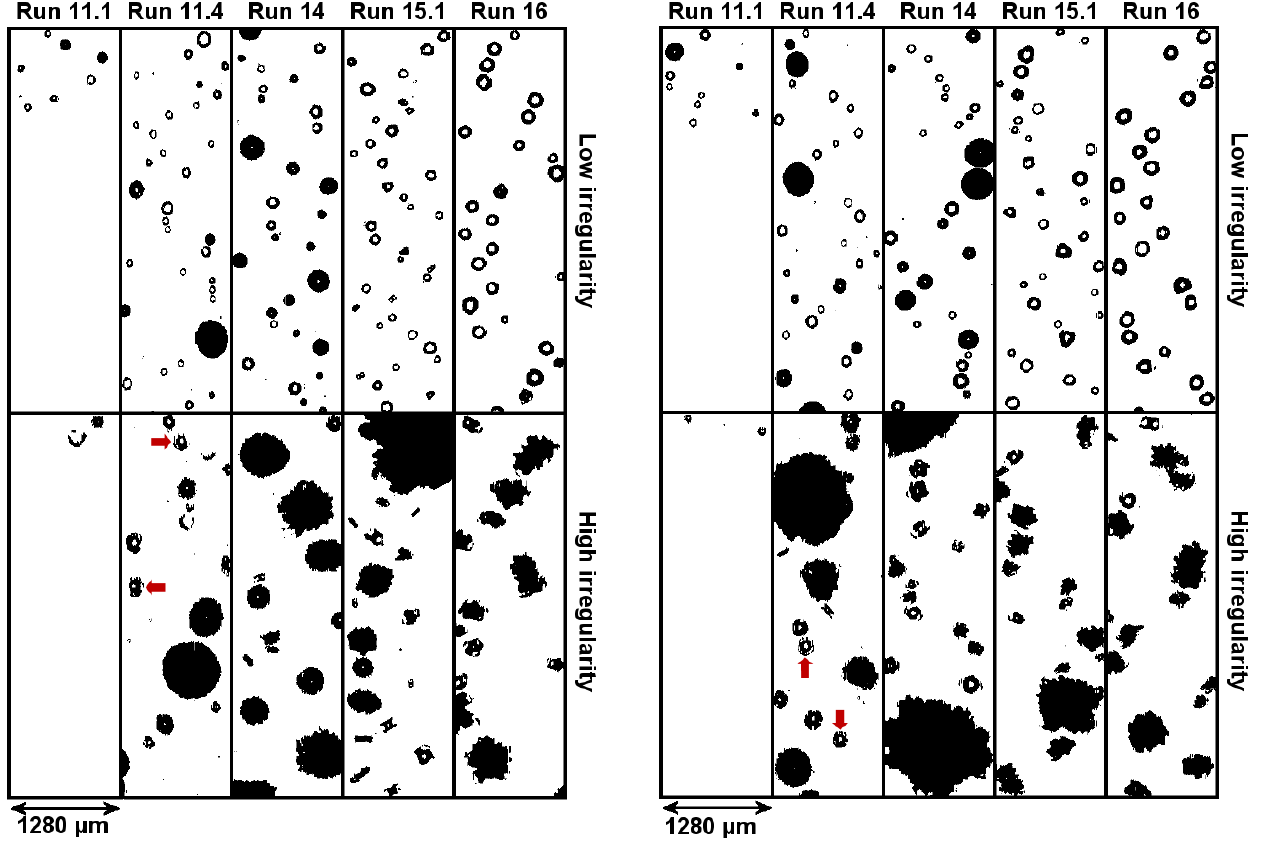
Figure 9. As in Fig. 8, but for